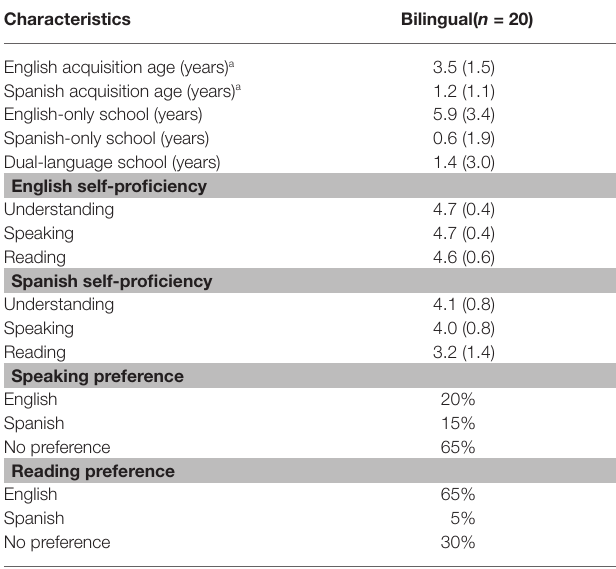
Table 2 outlines the characteristics of the bilingual group.